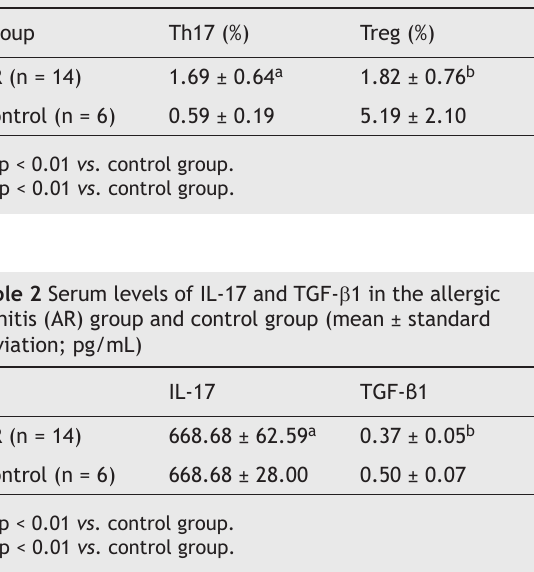
Table 1 Proportion of Th17 cells and regulatory T (Treg) cells in the allergic rhinitis (AR) group and control group (mean ± standard deviation).